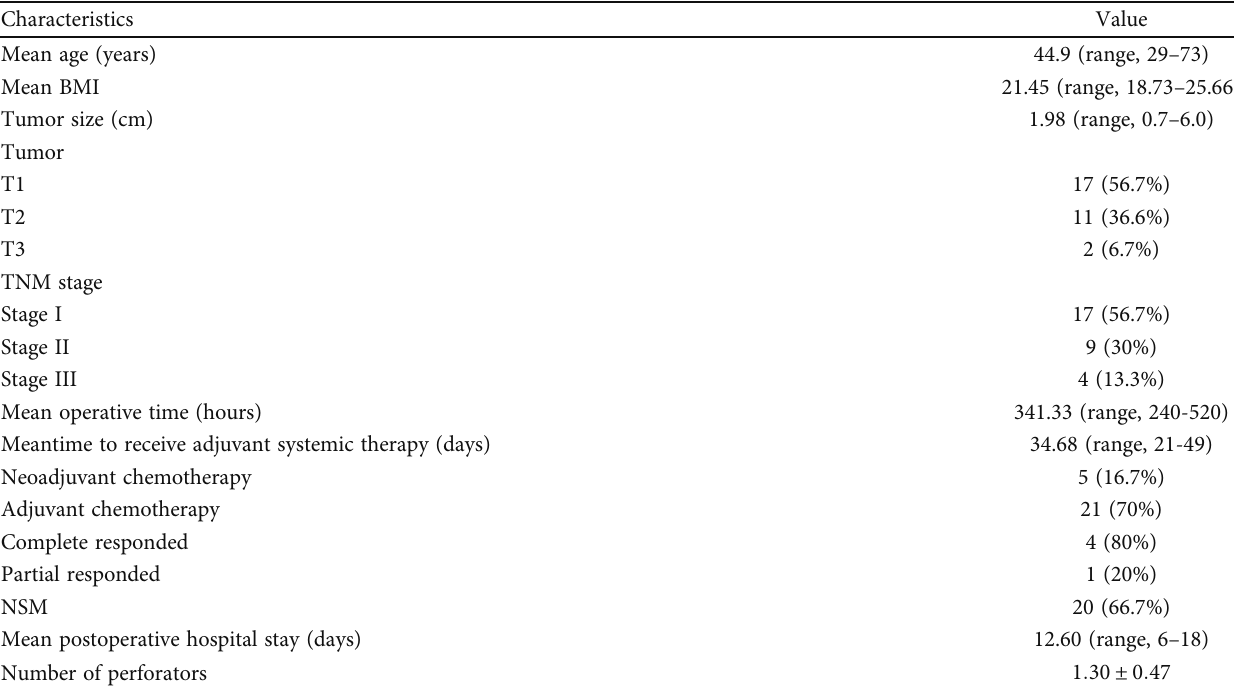
Table 1: Clinicopathological